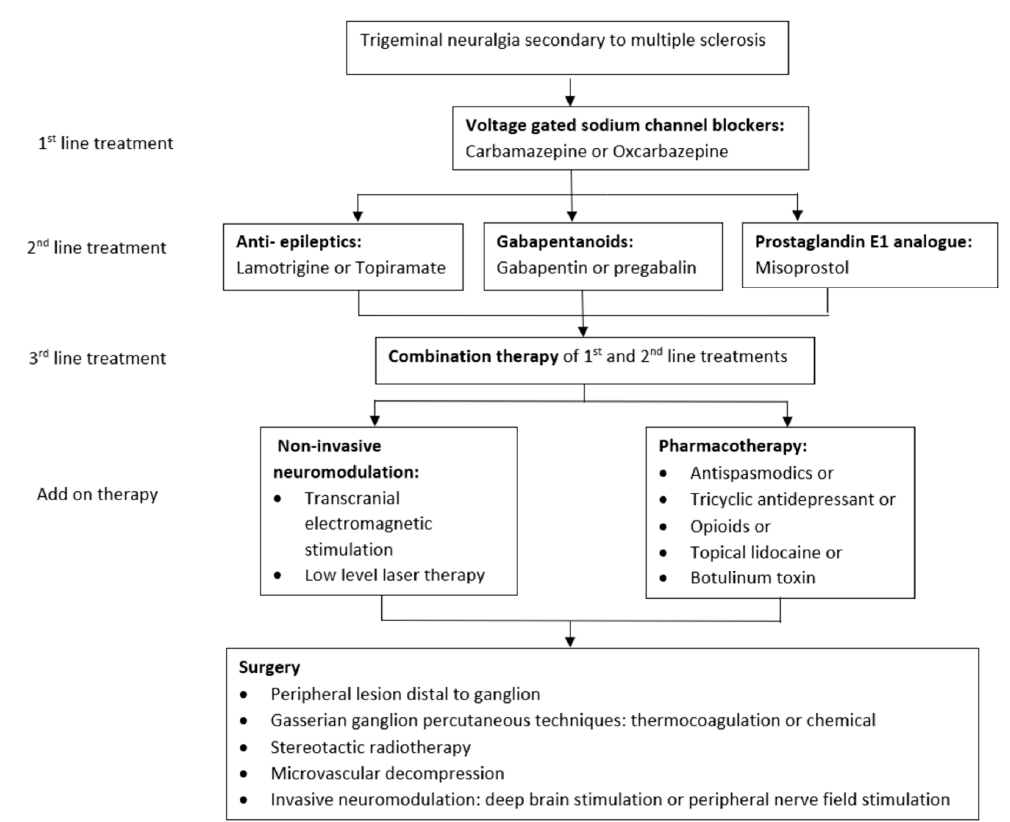
Figure A1. Suggested algorithm for treatment of trigeminal neuralgia secondary to multiple sclerosis.